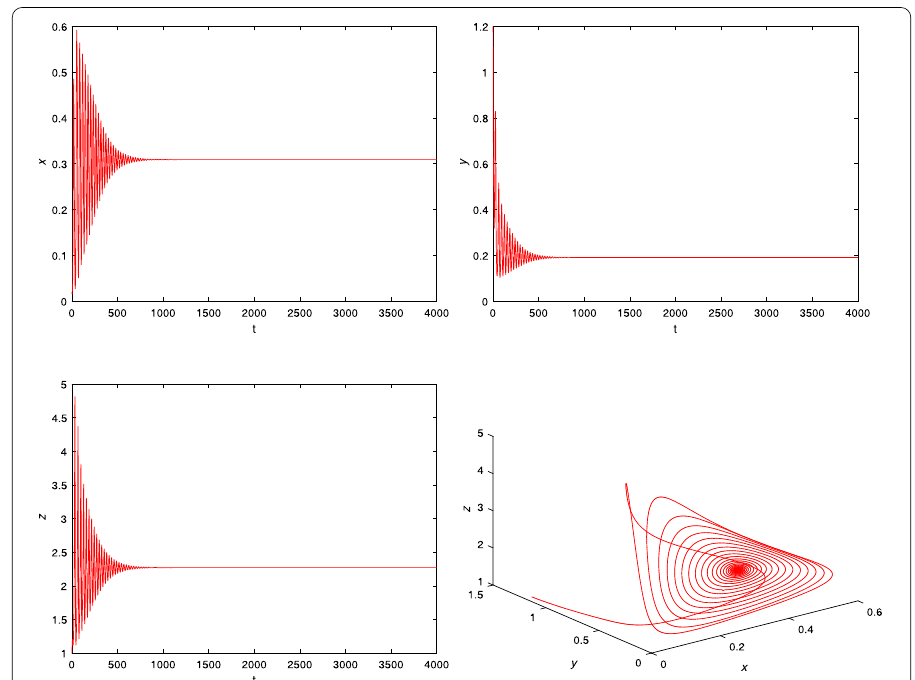
Figure 4 The trajectories and graphs of system (4.1) with τ = 12. The positive equilibrium E + is asymptotically stable